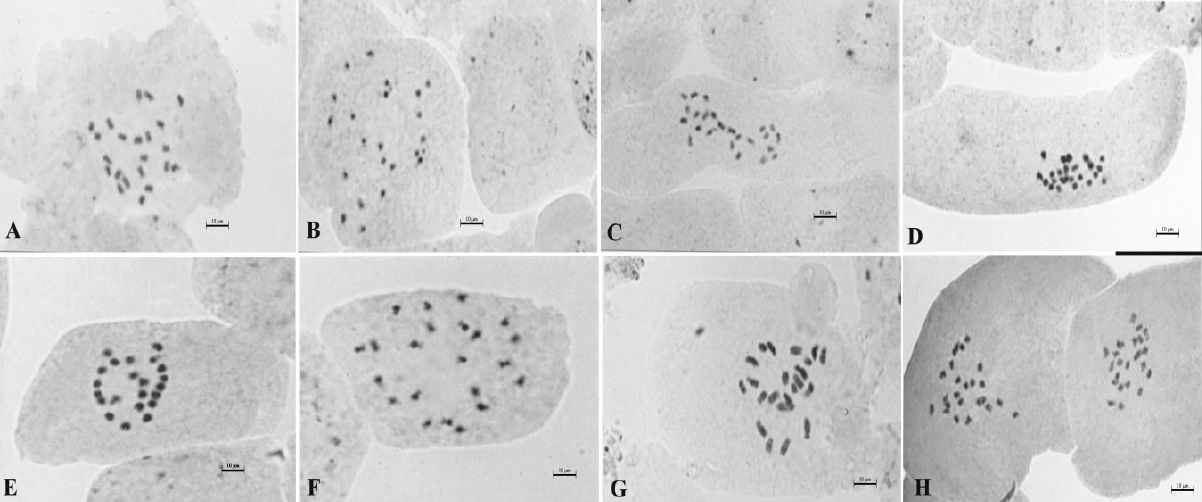
Figure 3. Photomicrographs of somatic metaphase chromosomes in root tip cells: Pentatropis nivalis (A), Glossonema boveanum (B), Sole- nostemma arghel (C), Cynanchum acutum (D), Pergularia tomentosa (E), Pergularia daemia (F), Gomphocarpus sinaicus (G), Calotropis pro- cera (H). Scale bar = 10